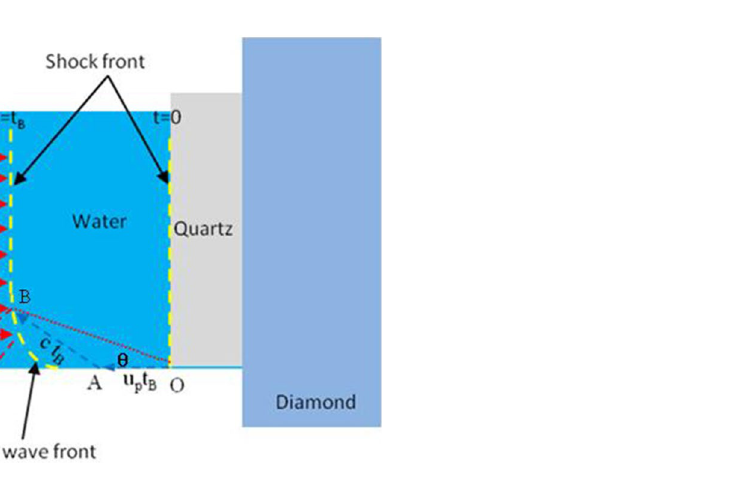
Figure 2. An illustration of how the shock wave front bends due to the propagation of the lateral rarefaction